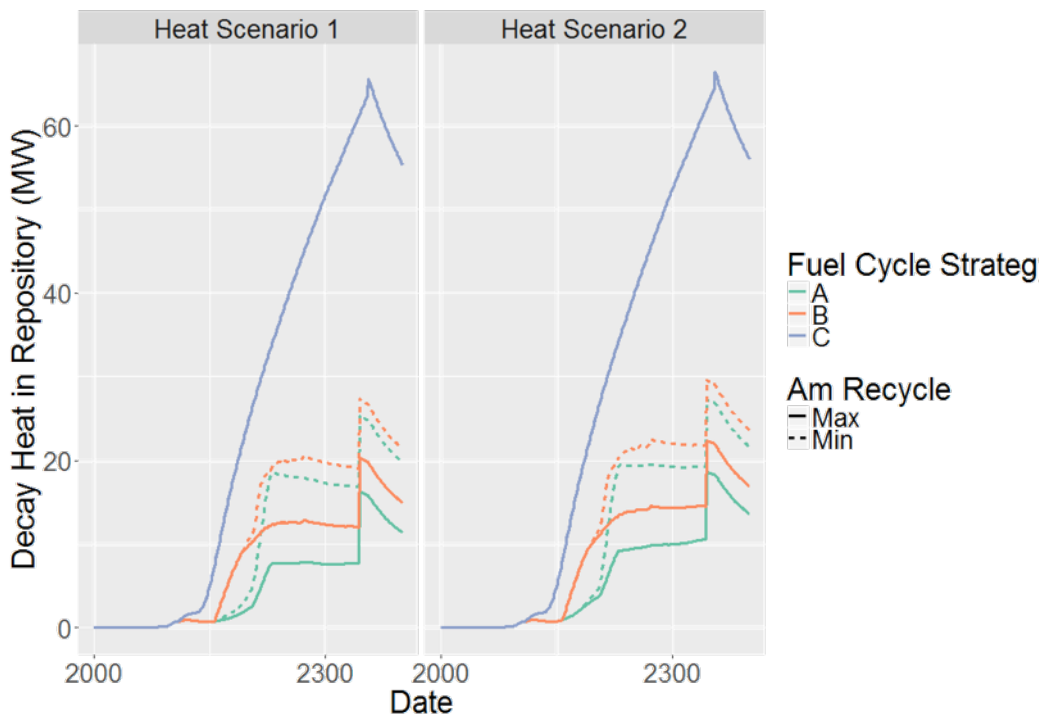
Figure 6. Cumulative decay heat, with decay heat from final cores considered.